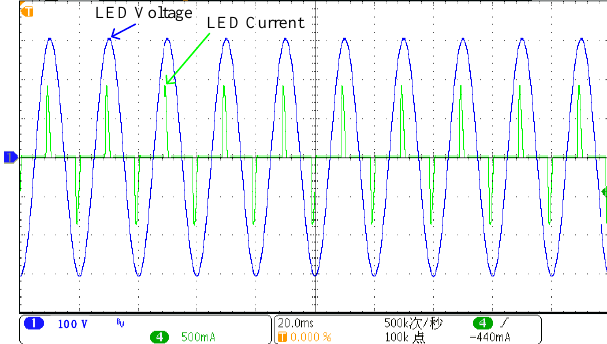
Figure 9. LED voltage and current waveforms.